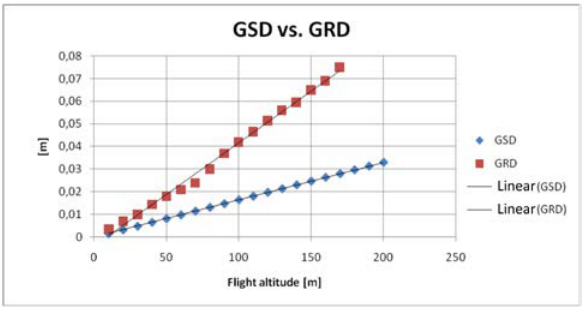
Figure 5. GSD vs GRD - for the camera Sony Nex-5 Figure 4b. Part of the RGB PIQuAT image aquired from miniMCA camera. Determination of GRD parameter on the basis of images obtained from higher altitudes was impossible due to parameters of Siemens star used in the PIQuAT. When analyzing the imagery data from successive UAV flights it can be seen that the greatest errors occurred in images acquired from 70-90m. This errors occurred due to dynamic changes of light conditions (cloud cover), which resulted in difficulties with the exact length measurement on Siemens star. For camera miniMCA each channel was analyzed separately. As in the case of the camera Sony Nex 5, obtained GRD parameter changes for each channel in a linear way with changes of altitude and varies in the range from 0.01 to 0.075 m for an altitude of 70 m. The biggest difference in the GRD parameter (between channels Master and Slave 1) occurred in the pictures obtained from a height of 30 m. However, the value of this difference was equal to 0.002 m, which demonstrate that camera should be considered as homogenous in this aspect. Figure No. 6 presents the averaged GRD parameter as a function of altitude, along with the theoretical GSD values.